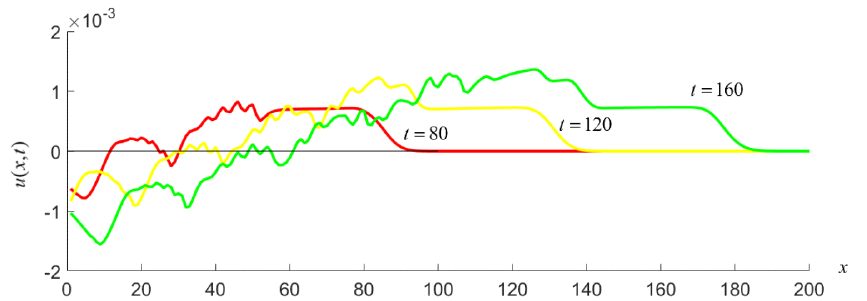
Figure 5. Displacement u(x,t) at different time moments versus the horizontal coordinate x for the compression–tension harmonic impulse.